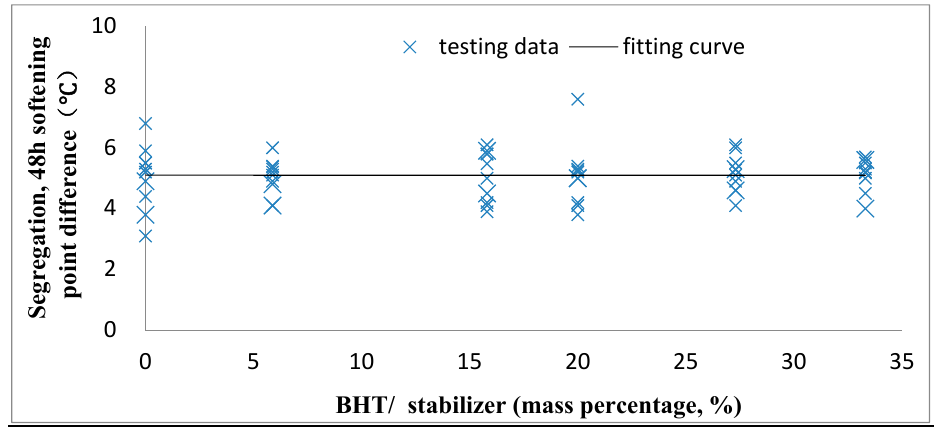
Figure 7. The 48-h segregation softening point difference with different BHT content.